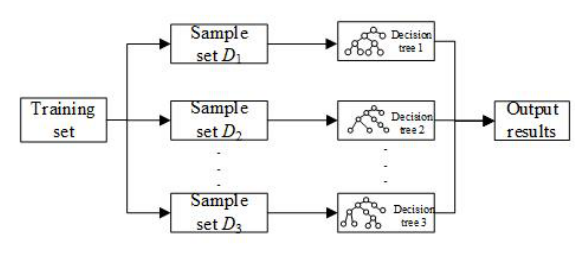
Fig. 3. Realization flow chart of RF prediction model